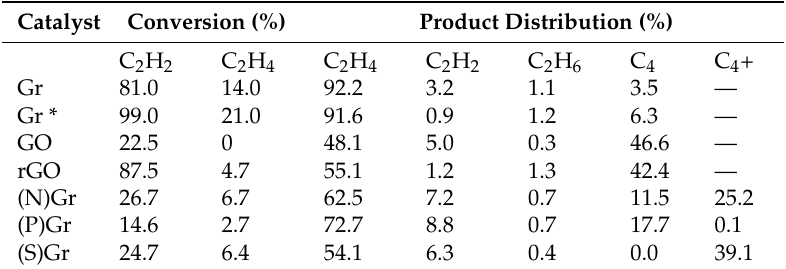
Table 3. Catalytic performances of graphene-based